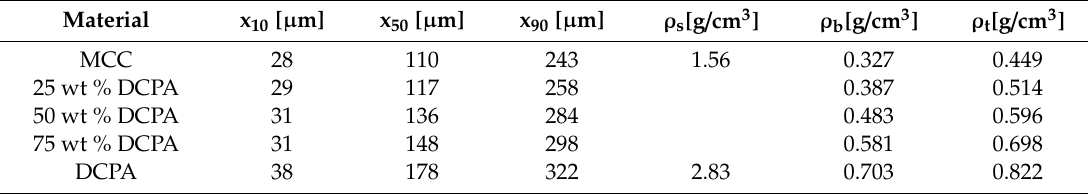
Table 1. Characteristic particle sizes, solid, bulk and tapped density for microcrystalline cellulose (MCC) and anhydrous dicalcium phosphate